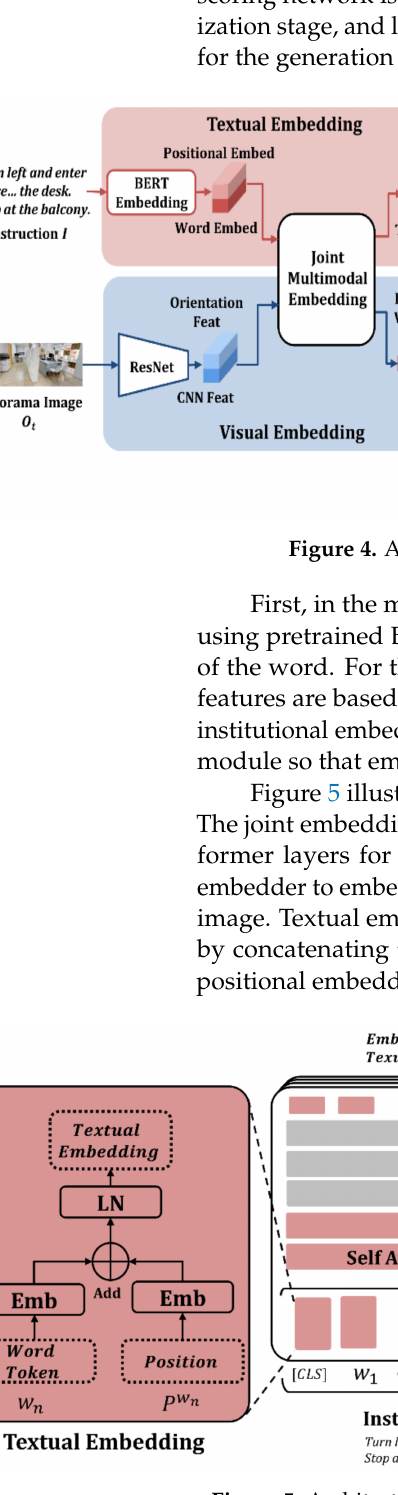
Figure 5. Architecture of joint multimodal embedding